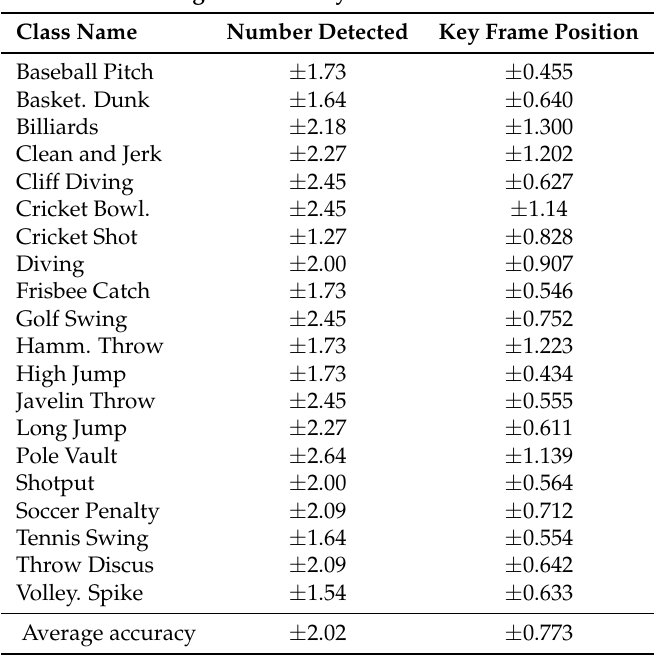
Table 1. Our technique can detect more than one key frame in a video. The table shows the difference in the number of key frames detected versus the automatically annotated ground truth as well as the position of these key frames relative to the ground truth in 20 classes of the UCF101 dataset.